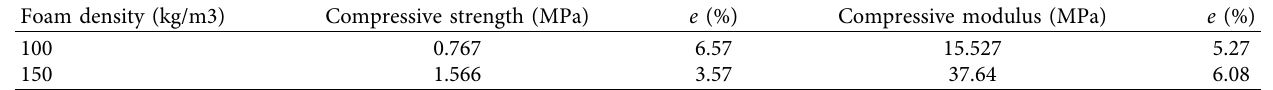
Table 2: Compressive properties of PU